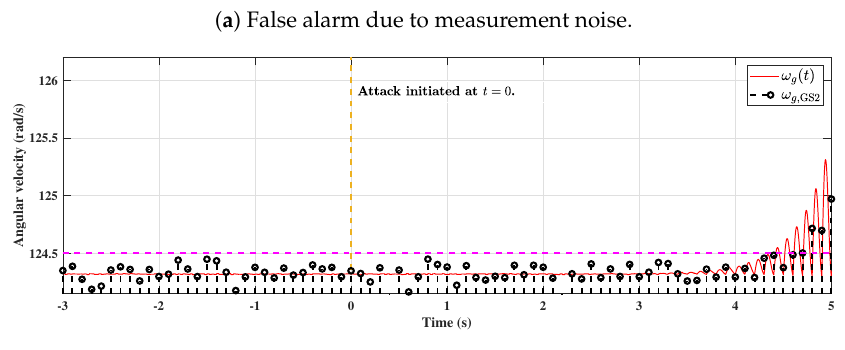
( b ) False alarm removed with reduced sampler weight. Figure 11. GS simulation with measurement